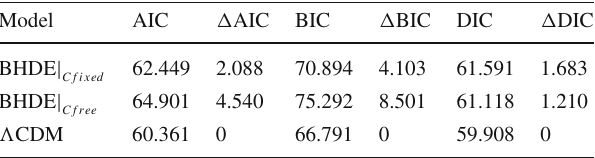
Table 2 The information criteria AIC, BIC and DIC for the examined cosmological models, along with the corresponding differences (cid:2) IC ≡ IC − IC min